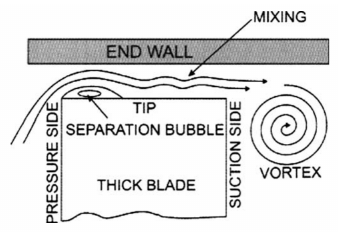
Figure 3. Leakage of the flow through the blade tip visualized with respect to the rotor blade